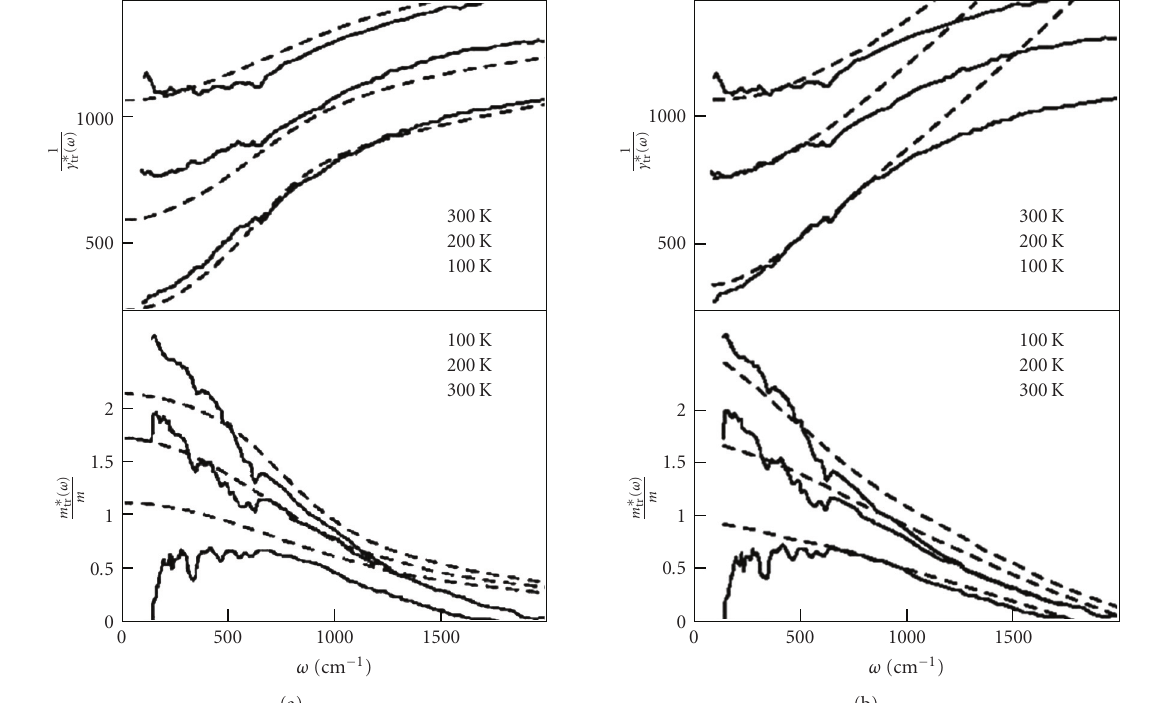
Figure 5: (a) Experimental transport scattering rate γ ∗ with α 2 F ( ω ) due to EPI which is described in text (dashed lines). (b) Comparison with the marginal Fermi liquid theory—dashed lines. m ∗ tr From [3–5, 99].